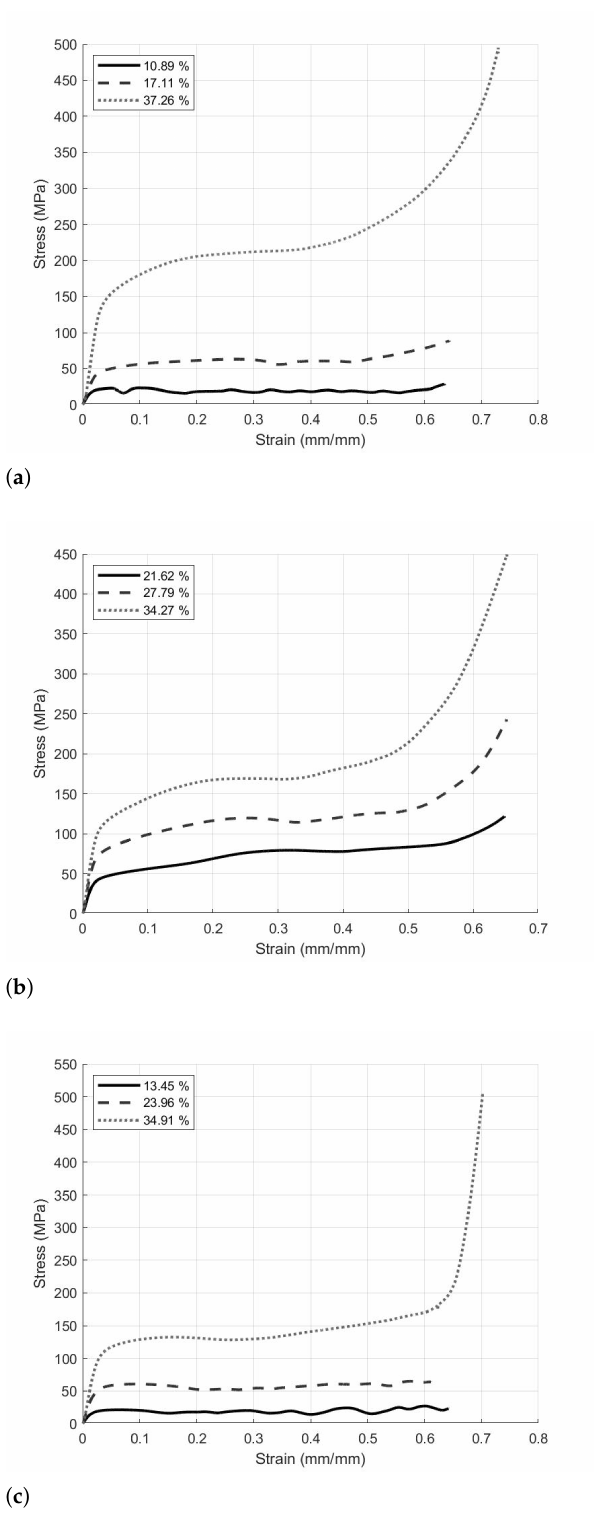
Figure 5. Representative stress-strain response curves of: ( a ) Diamond lattice design, ( b ) I-WP Lattice design, ( c ) Primitive lattice